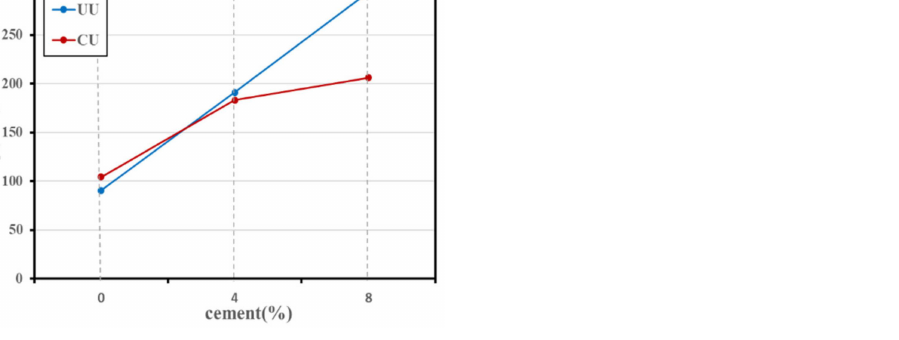
Figure 16. Comparison of shear strength of the samples for triaxial Consolidated Undrained and Unsaturated Unconsolidated Undrain test.